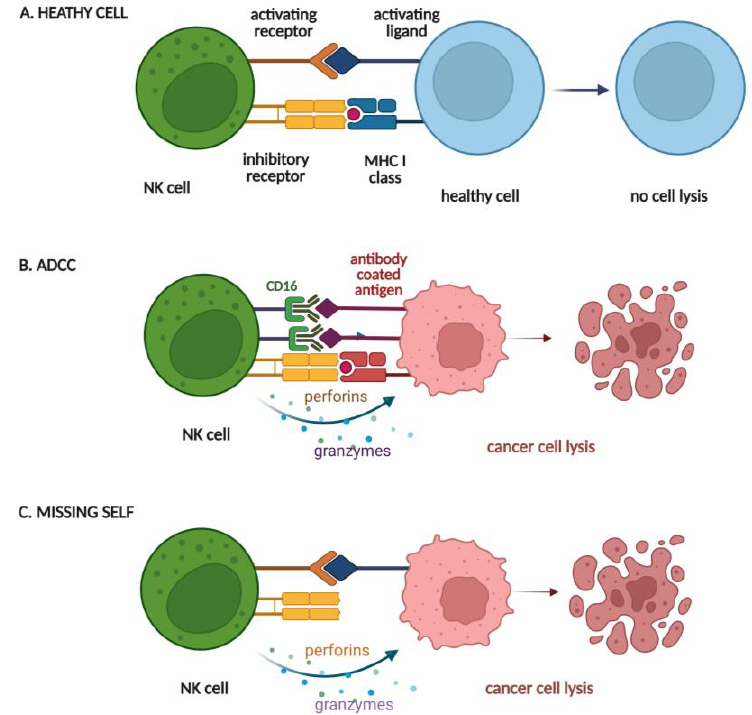
Figure 1. Schematic presenting mechanisms of recognition of healthy cell ( A ), antibody-coated tar- get cell ( B ), or cancer cell missing MHC-I expression ( C ) by NK cell, followed by degranulation of NK cell ( B , C ) and cancer cell lysis.